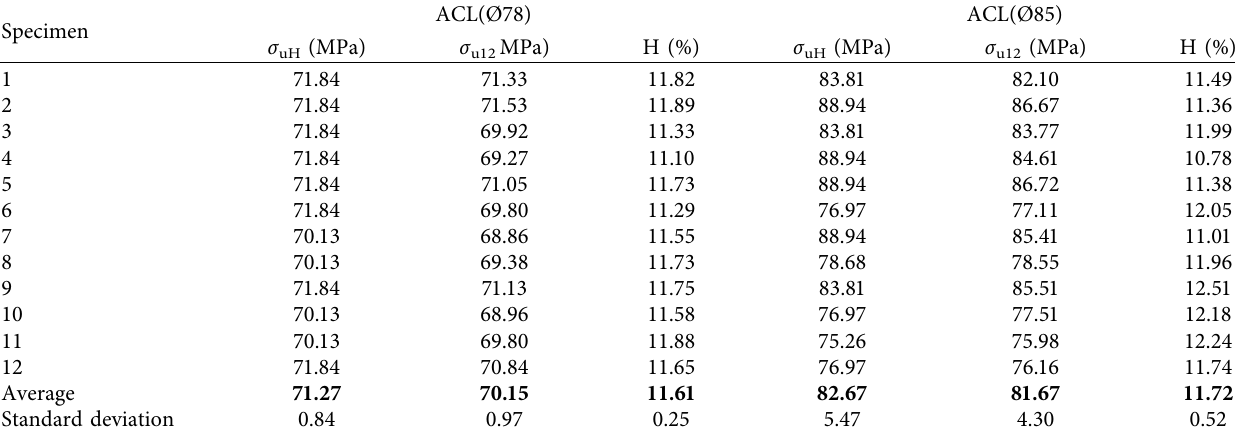
Table 5: Failure stresses in axial compression, diameter 78cm and 85cm.